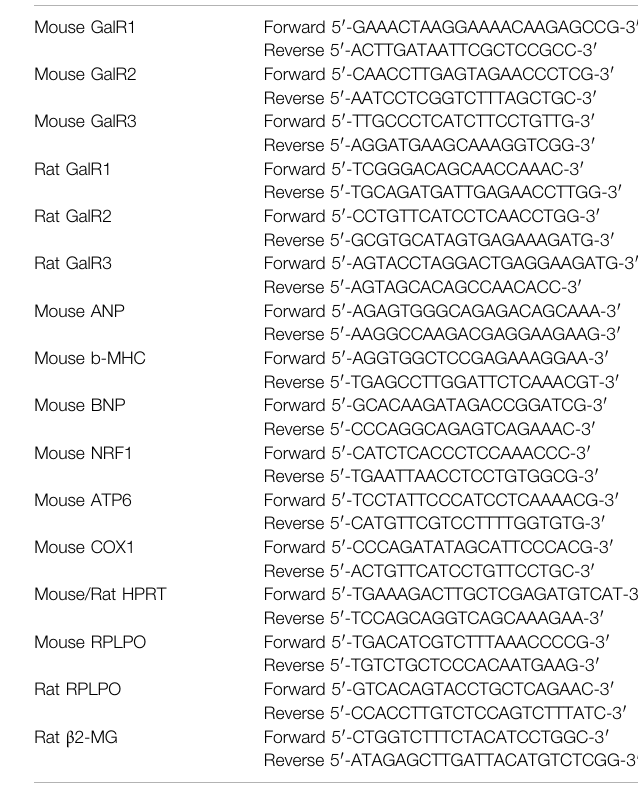
TABLE 1 | Real-time qPCR